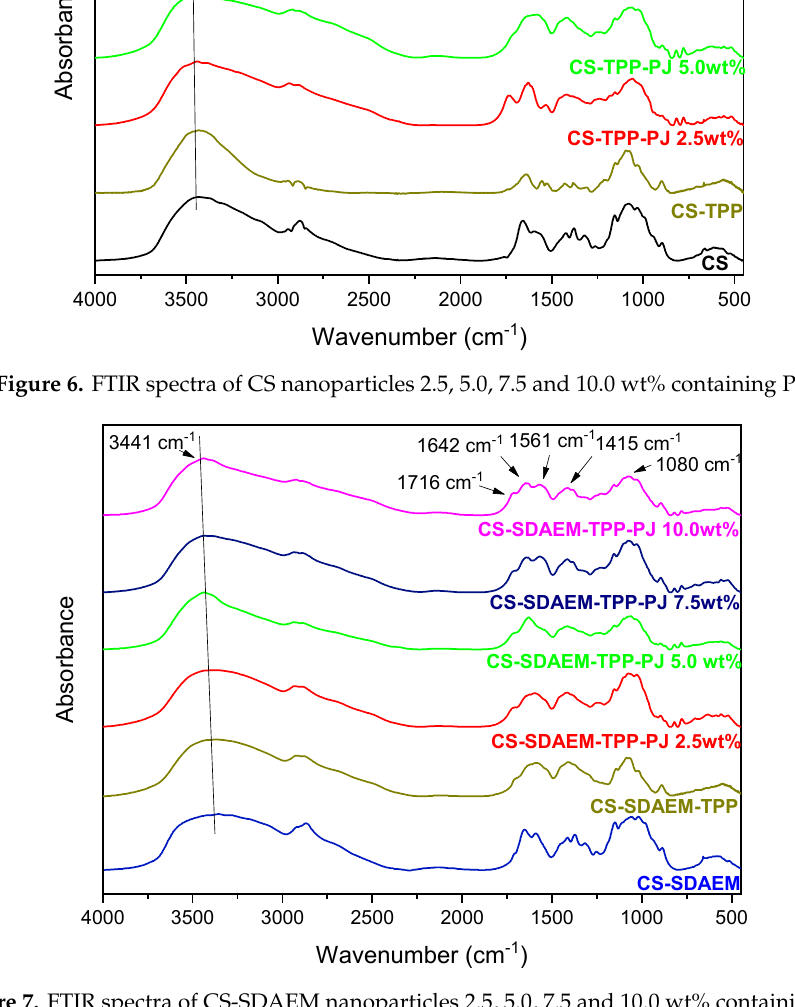
Figure 7. FTIR spectra of CS-SDAEM nanoparticles 2.5, 5.0, 7.5 and 10.0 wt% containing PJ.